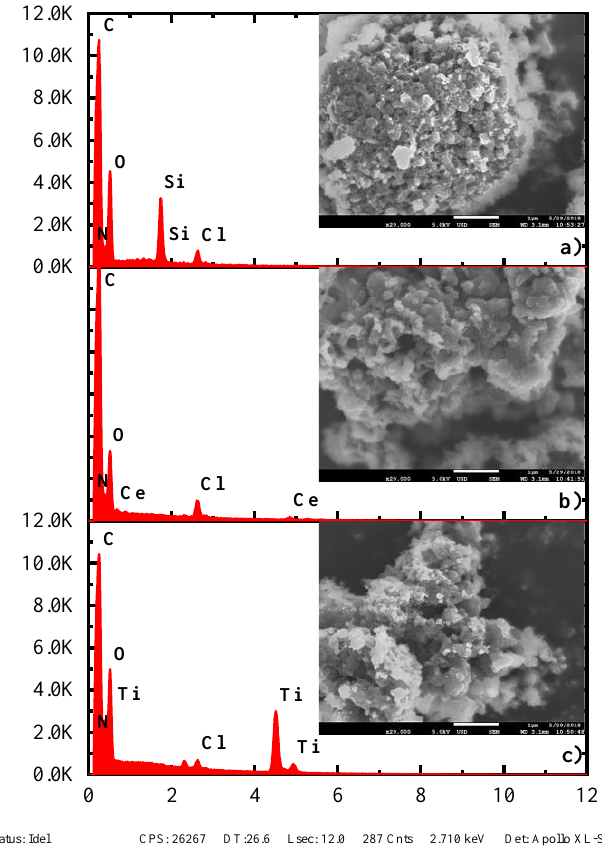
Figure 8. EDS spectra and micrographs obtained at 20,000 magnification of nanocomposites: ( a ) SiO 2 /PANI, ( b ) CeO 2 /PANI, and ( c ) TiO 2 A/PANI.